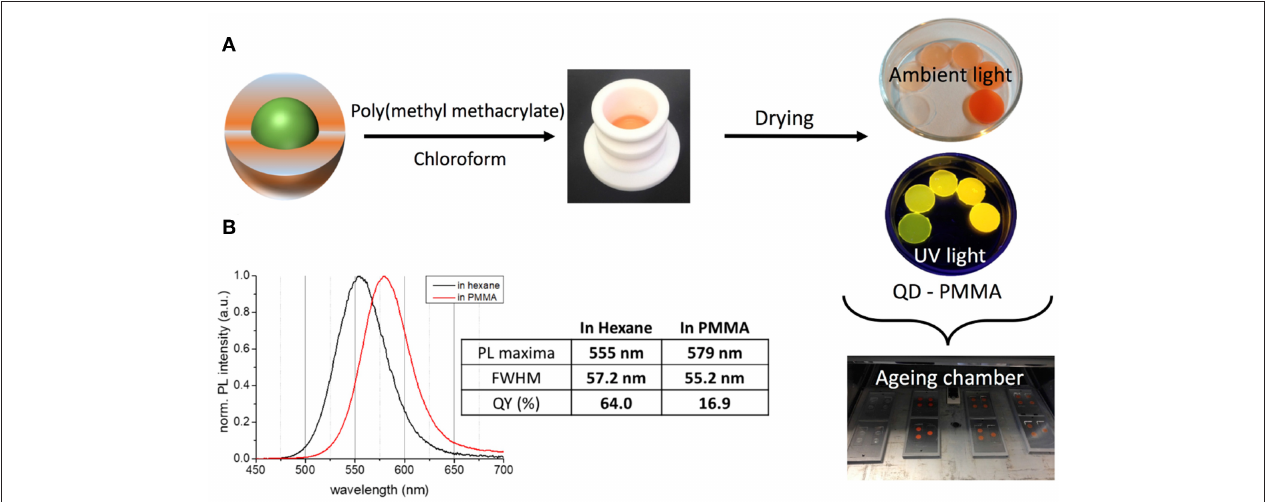
FIGURE 3 | (A) Processing of the QDs for aging experiments using a PMMA matrix and different concentrations of QDs. (B) Comparison of the PL properties of InZnP/ZnSeS/ZnS (thick shell) QDs in colloidal solution (hexane) and after embedding in the PMMA